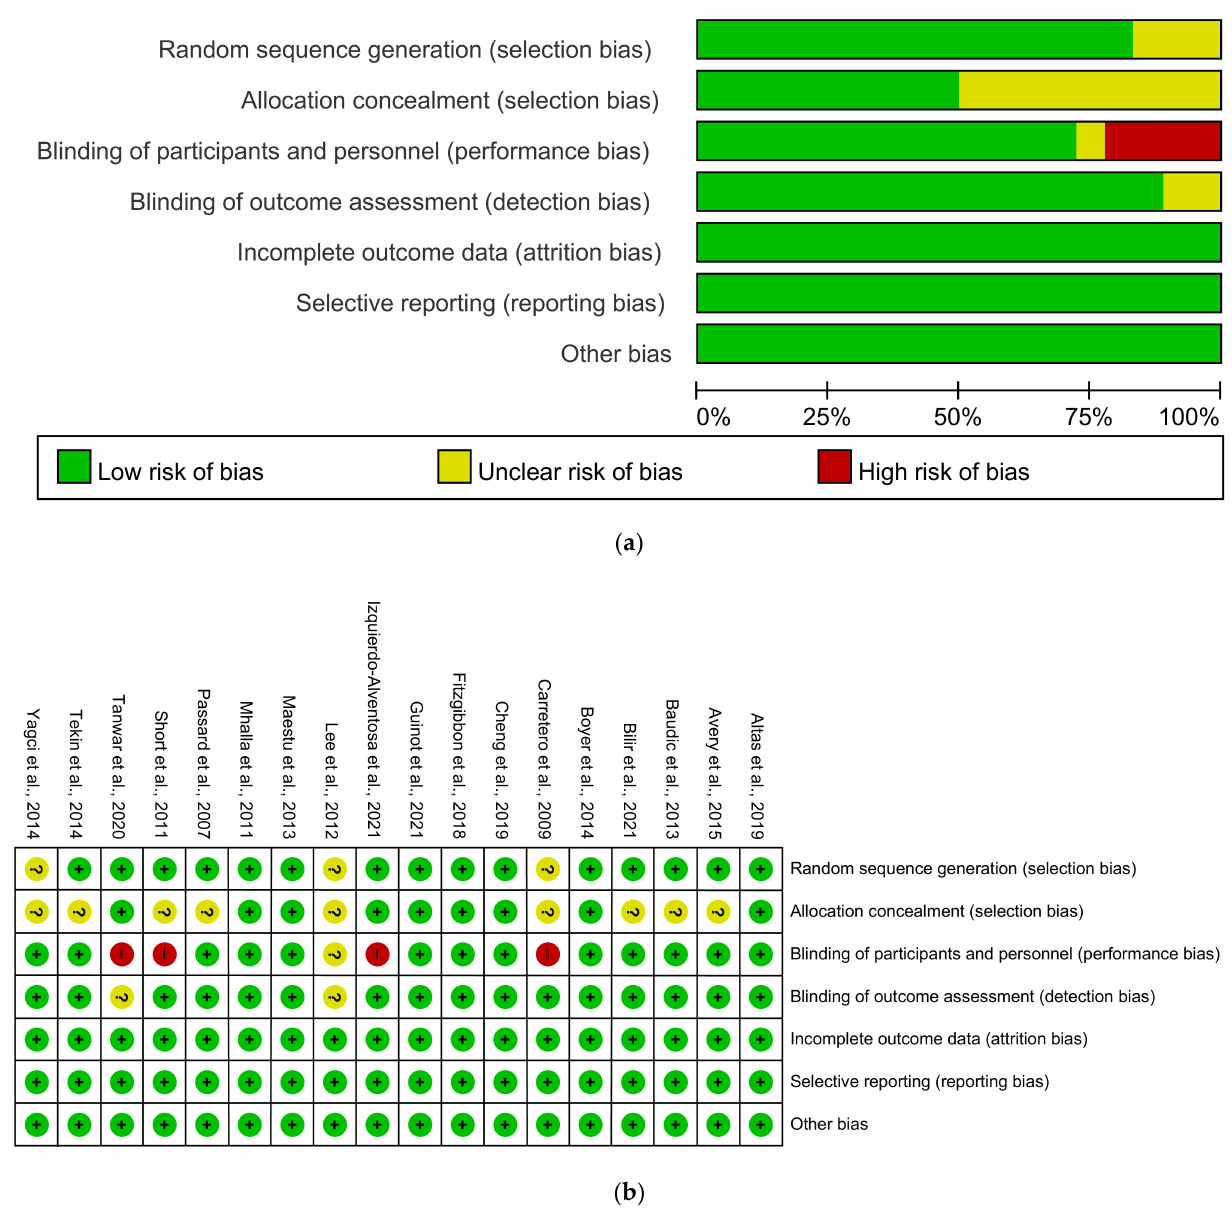
Figure 2. Results of risk of bias assessment. ( a ) Risk of bias graph; ( b ) Risk of bias